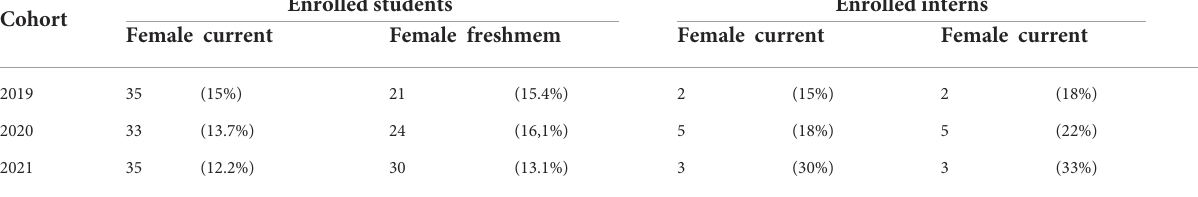
TABLE 6 Comparison of female students vs. female internship